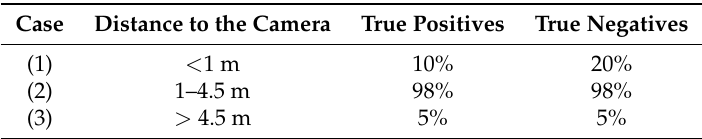
Table 4. Distance to the camera in the fall detection